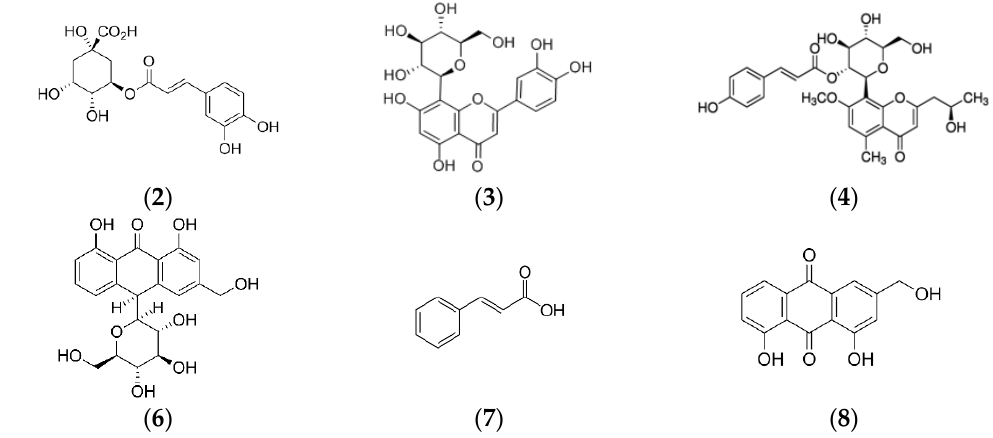
Figure 3. Chemical structures of eight identified compounds by HPLC-MS in AVE. ( 1 ) aloesin; ( 2 ) chlorogenic acid; ( 3 ) orientin; ( 4 ) aloeresin D; ( 5 ) aloin B; ( 6 ) aloin A; ( 7 ) cinnamic acid; ( 8 ) aloe emodin.